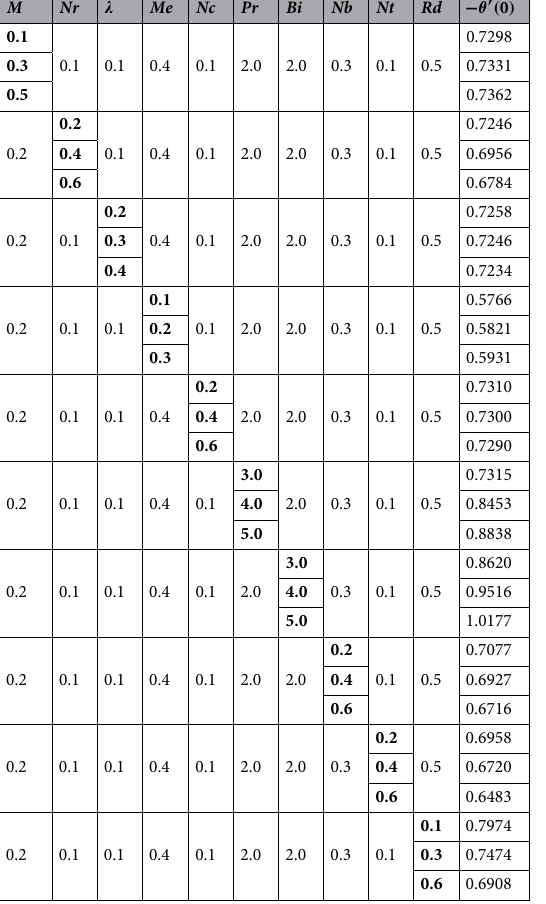
θ ′ ( 0 ) for specific magnitudes of M , Nr , (cid:31) , Me , Nc , −